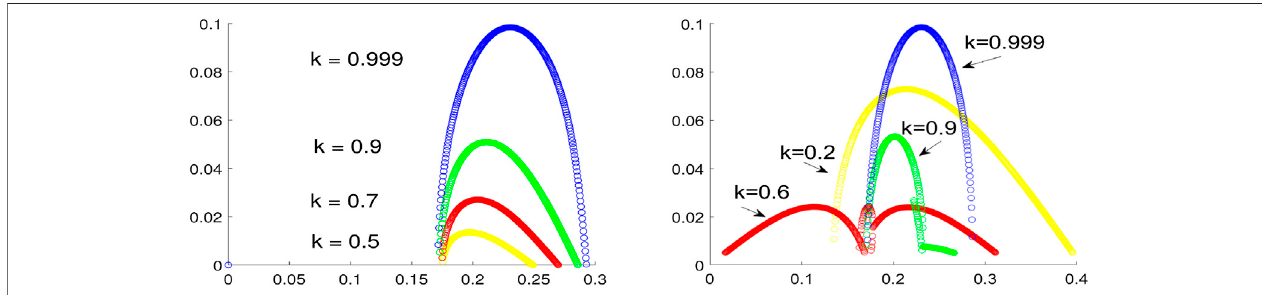
FIGURE7 | Instabilityrate Re ( Λ ) versus theFloquet parameter θ forthe amplitude-normalized double-periodic wave Eq. 2.15 (left) and the double-periodic wave Eq. 2.16 (right) . The values of k are given in the